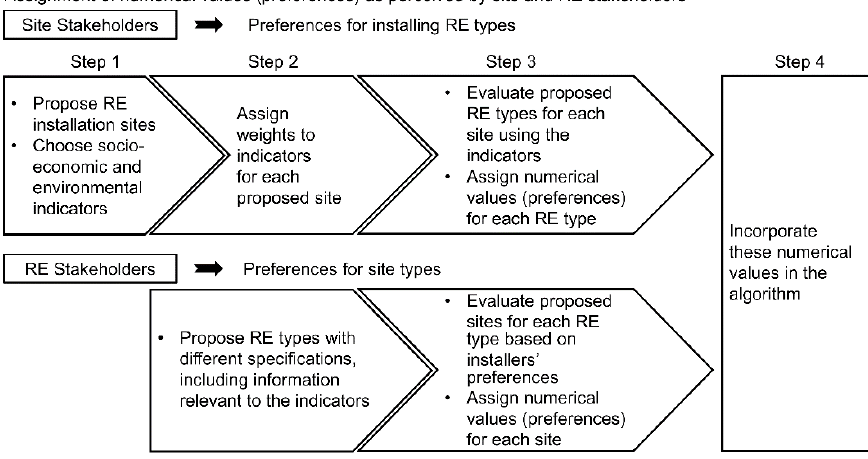
Figure 2. Assignment of numerical values (preferences) as perceived by site and RE stakeholders.